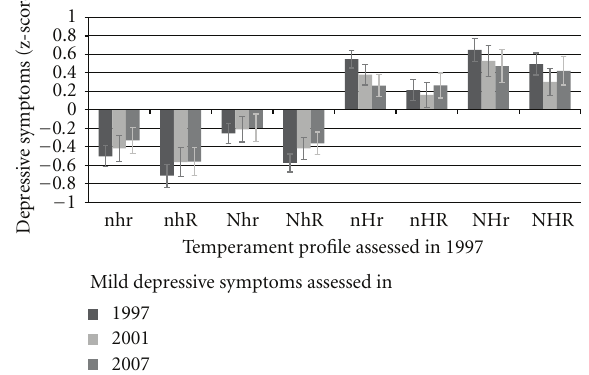
Figure 2: Standardized scores (mean = 0, SD = 1) of mild depressive symptoms (modified BDI) in di ff erent temperament combinations. 95% confidence intervals included. Sex and birth year were controlled. NHR = sensitive; NHr = explosive; NhR = passionate; Nhr = adventurous; nHR = cautious; nHr = methodical; nhR = reliable; nhr =